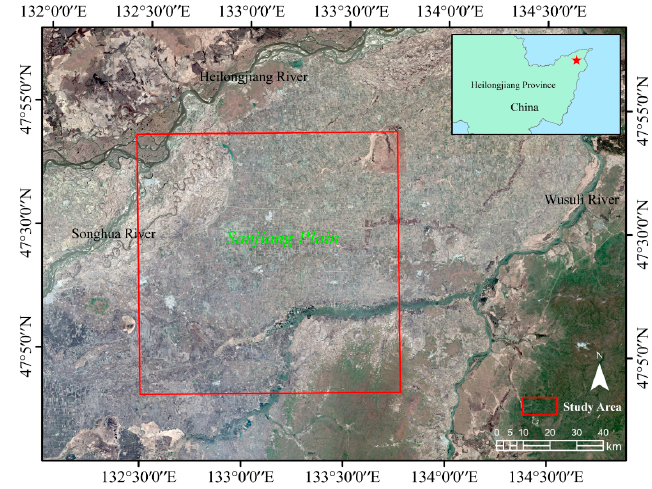
Figure 2. Map of the study area.